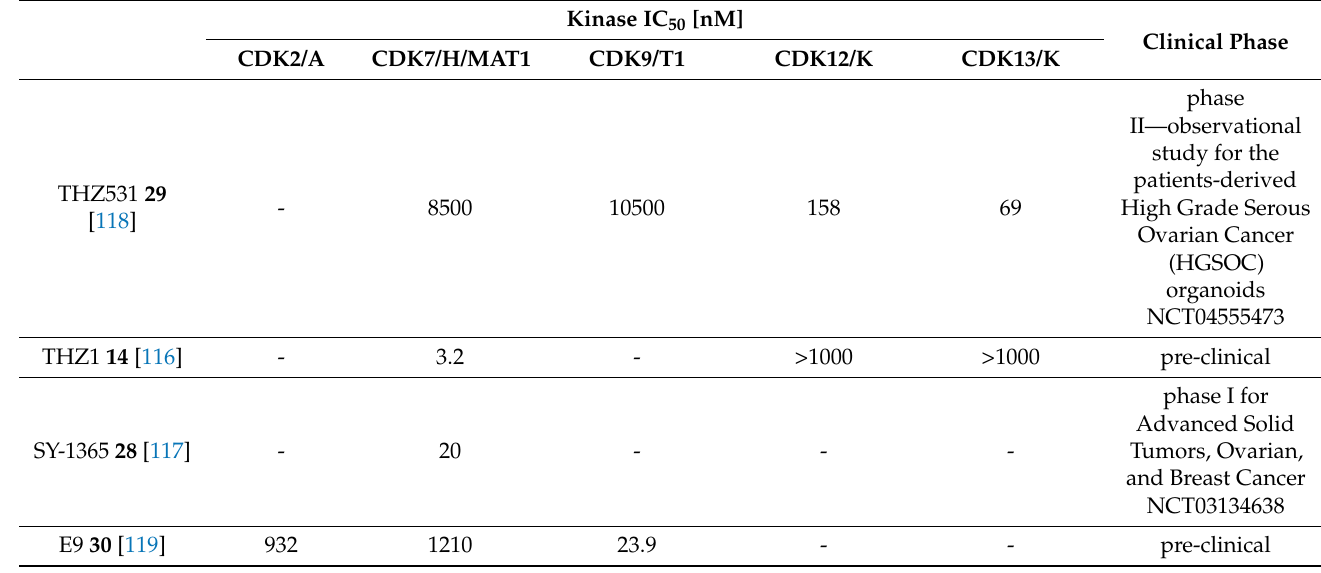
Table 6. Type VI CDK inhibitors under clinical